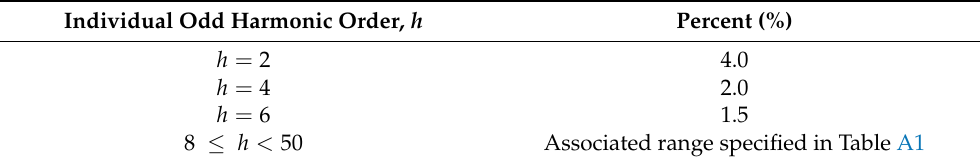
Table A4. IEEE 1547 Maximum even harmonic current distortion in percent of rated